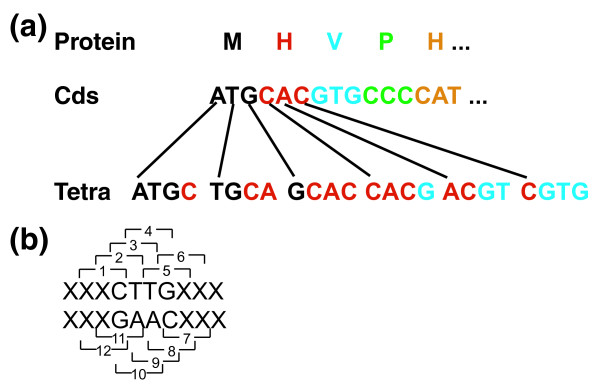
Schematic of how tetranucleotide frequency relates to reading frame and potential codons. (a) Tetranucleotide frequencies are calculated independently of reading frame with a 1-bp sliding window; thus, they may sample a complete codon or span two partial codons. (b) Because reverse complementary pairs are summed together, both strands are sampled. Therefore, depending on the coding strand and reading frame, there are 12 potential codons sampled by each tetranucleotide.